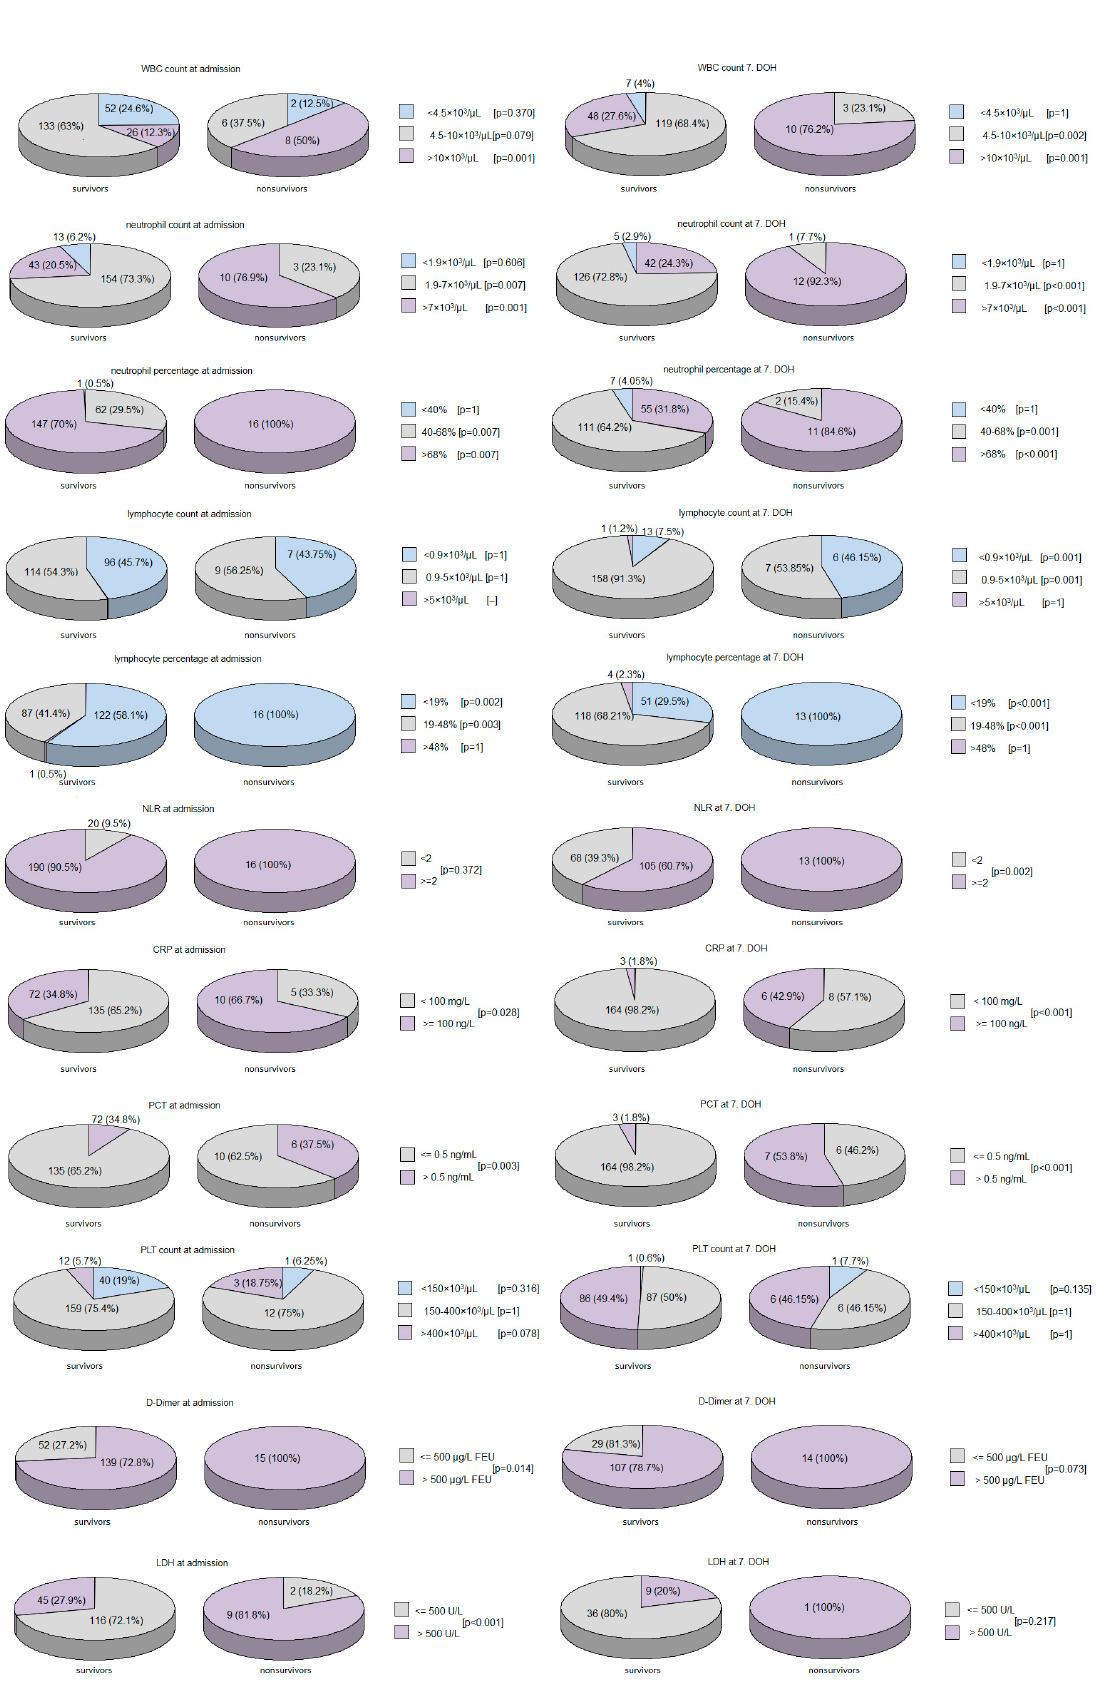
Figure 2. Comparison of patients’ laboratory parameters (as categorical variables) between survivors and non-survivors. Variables are presented as the number of patients and percentages and